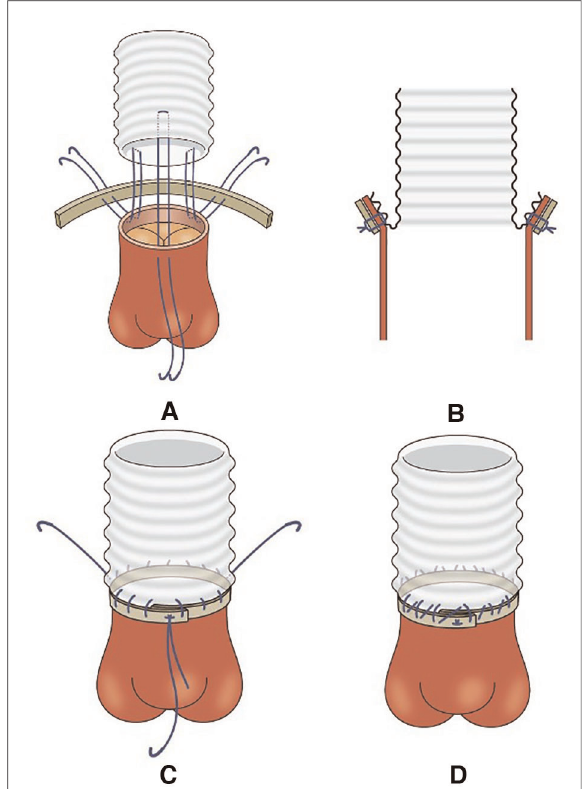
FIGURE 1 Illustration of the modi fi ed turn-up technique. ( A ) A felt strip was placed on the external border of the aortic wall, and three U-stay sutures were placed between the graft and aorta at regular intervals. ( B ) The three U-stay sutures were tied down and fi xed by everting the end of the graft. ( C ) The fi rst round of continuous sutures. The anastomosis was sutured continuously and sutures were tied each time it reached each fi xation site. ( D ) The second round of continuous sutures. Sutures were tied each time it reached the fi xation site same as the fi